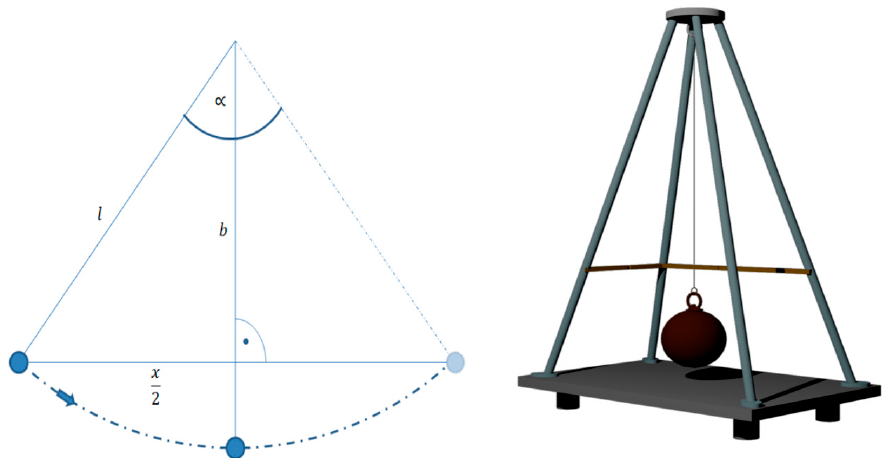
Figure 2. Left: Mathematical model of the mechanical pendulum for the quantification of the pendulum’s movement with the length of pendulum l, the angle of release α , and the projected path x. Right: pendulum with weight, mounted on a Kistler force plate.